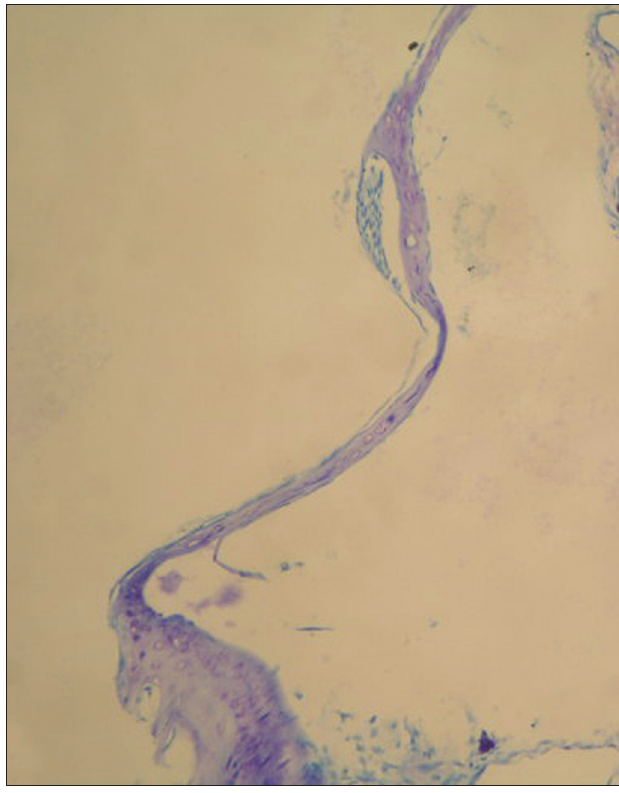
Figure 3. In tympanic membrane evaluated as 2 point scale from group C, moderately thickened and sclerotic plaque are shown (toluidine blue, original magnification x200).